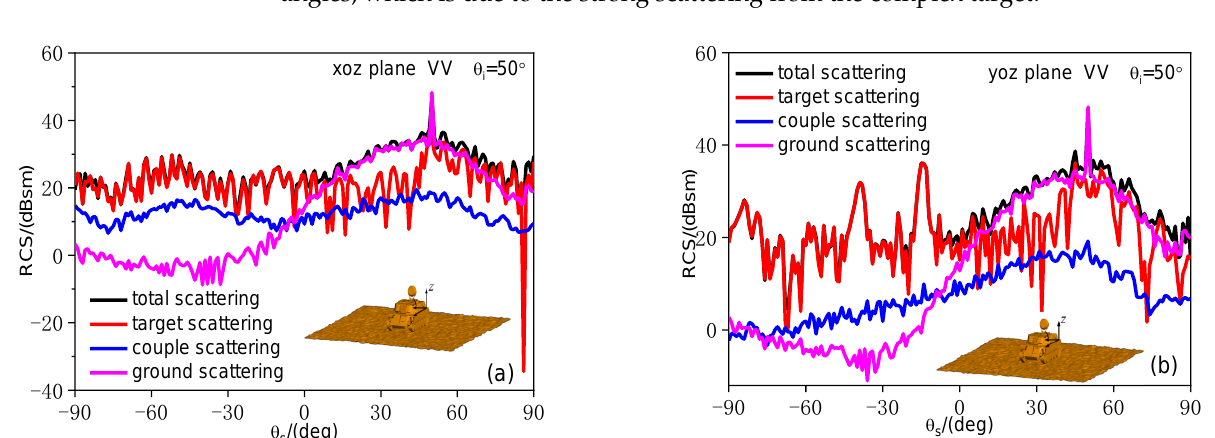
Figure 12. Bistatic scattering of ZSU-234 antiaircraft gun on rough ground ( a ) xoz plane; ( b ) yoz plane.